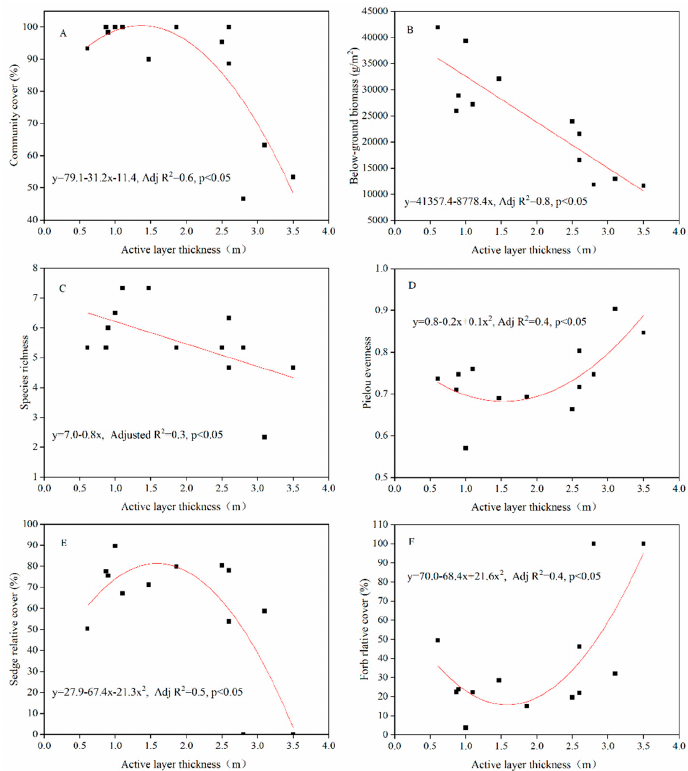
Figure 3. Relationships between vegetation indices and the active layer thickness in the permafrost sites. Notes: ( A ), community cover; ( B ), below-ground biomass; ( C ), species richness; ( D ), Pielou evenness; ( E ), sedge relative cover; and ( F ), forb relative cover. N = 13; data were averaged for the site level.